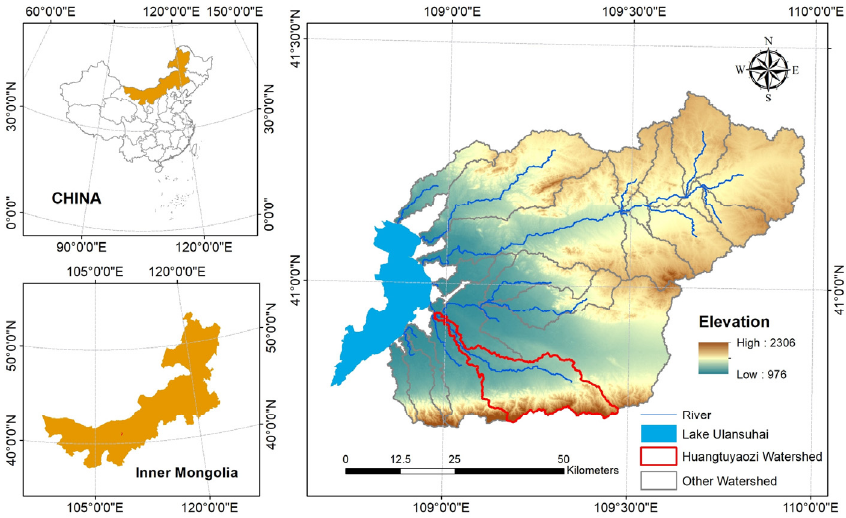
Figure 1. Location of the Huangtuyaozi (HTYZ) watershed and its relative position with Lake Ulansuhai, China.